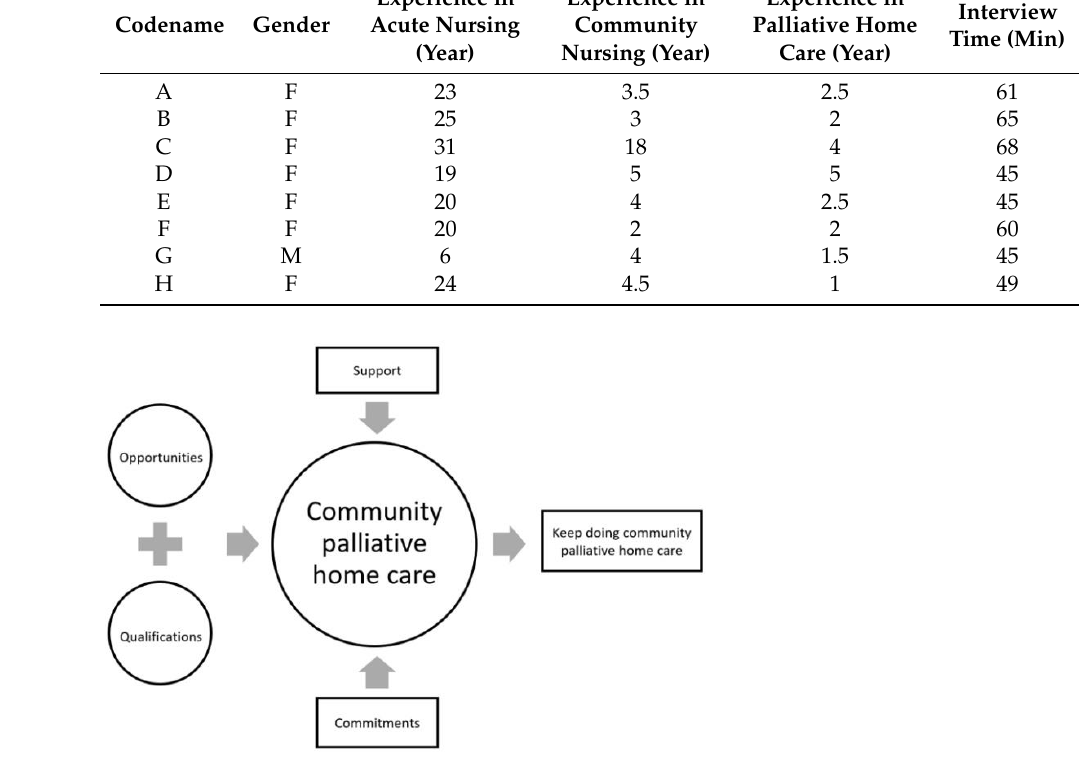
Figure 1. Themes from the